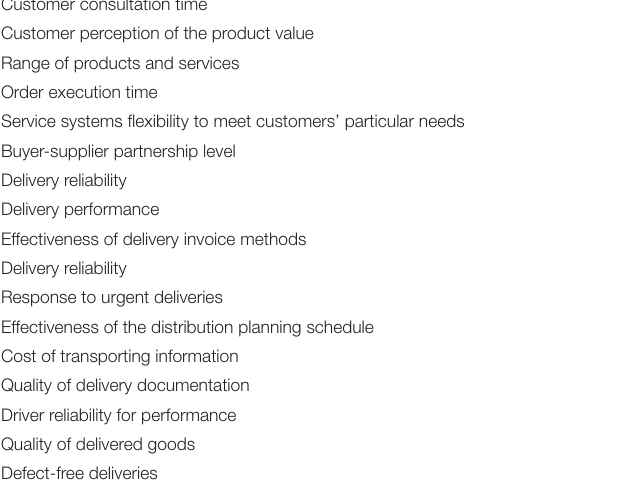
TABLE 5 | Performance metrics for the customer.